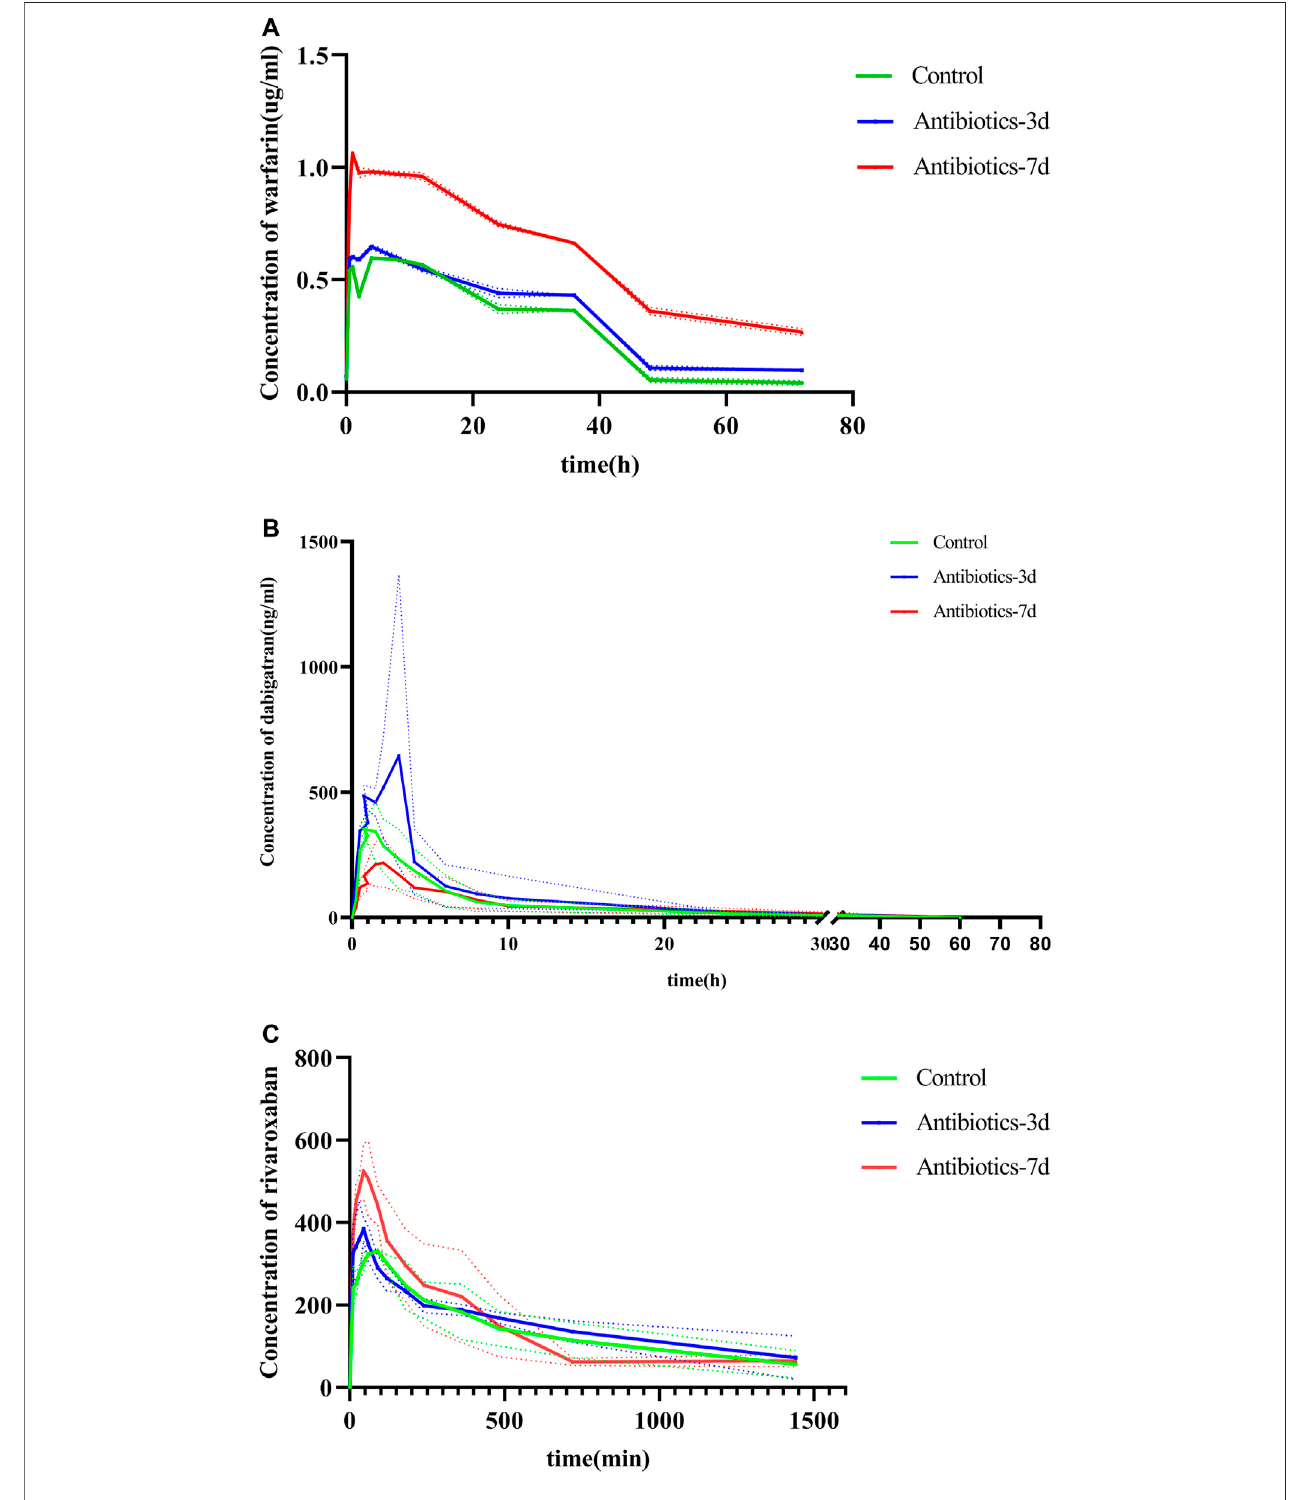
FIGURE 4 | The concentration of oral anticoagulants in the plasma over time. (A) Warfarin, (B) dabigatran, and (C) rivaroxaban. Comparison of drug-time curves among the control group, antibiotic treated for 3 days group, and antibiotic treated for 7 days group. Note: Different colors represent the different groups, broken lines are measured values, dashed lines are errors, and curves are fi tted by measured data.